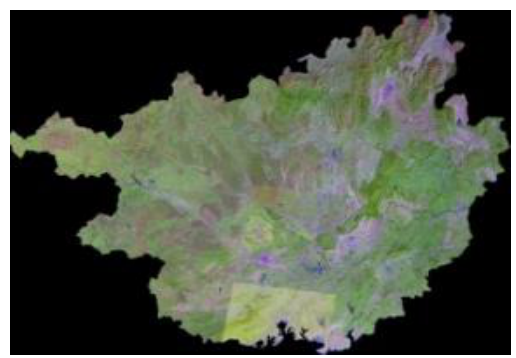
Figure 2. Guangxi TM false color composite image